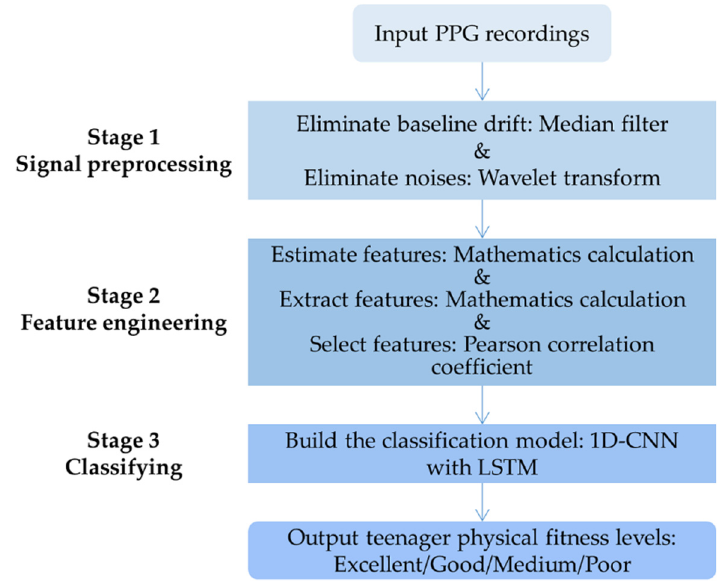
Figure 2. Framework of the proposed evaluation system.